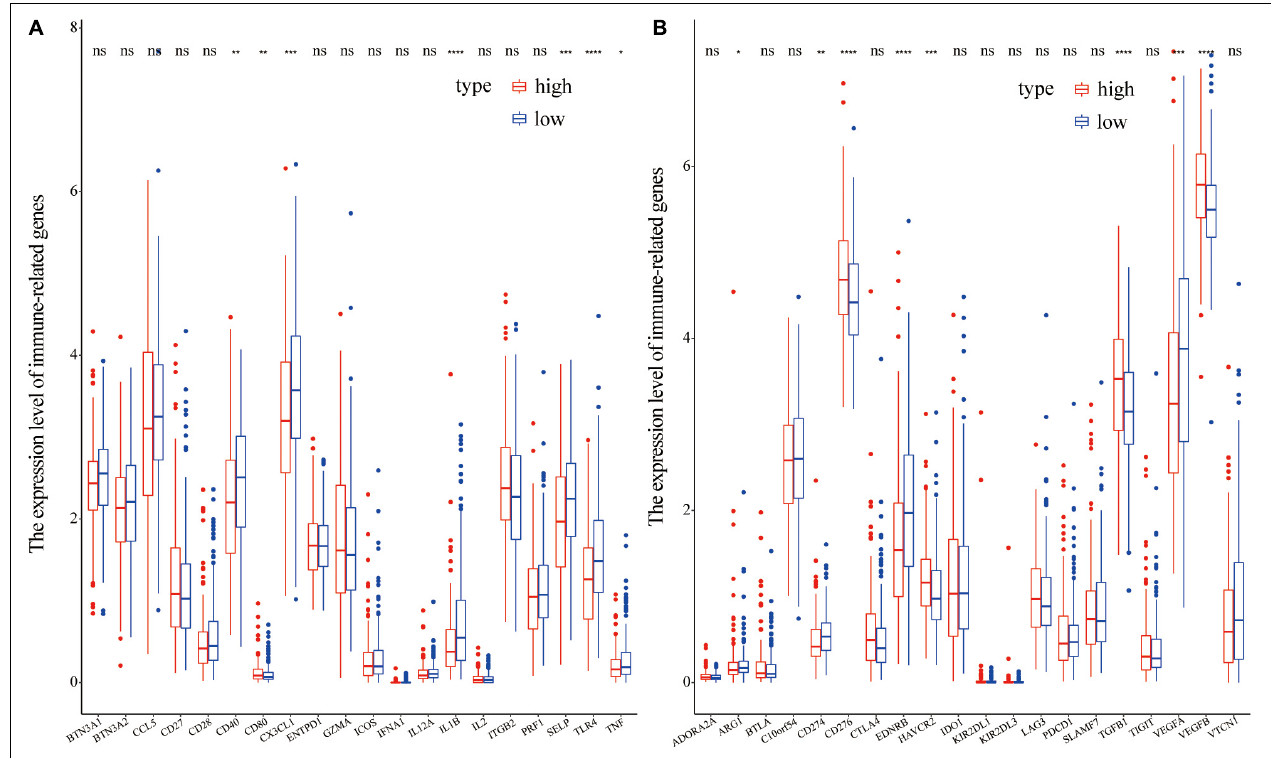
FIGURE 10 | Differential expression of immunoregulatory genes in different groups. (A) Differential expression of immune-stimulatory genes in different groups; (B) Differential expression of immune-suppressive genes in different